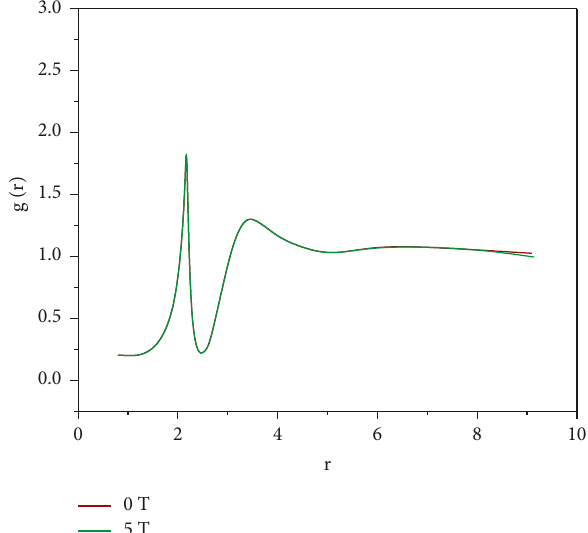
Figure 3: Effect of magnetic field on microstructure of pure water ( r ) g O − H